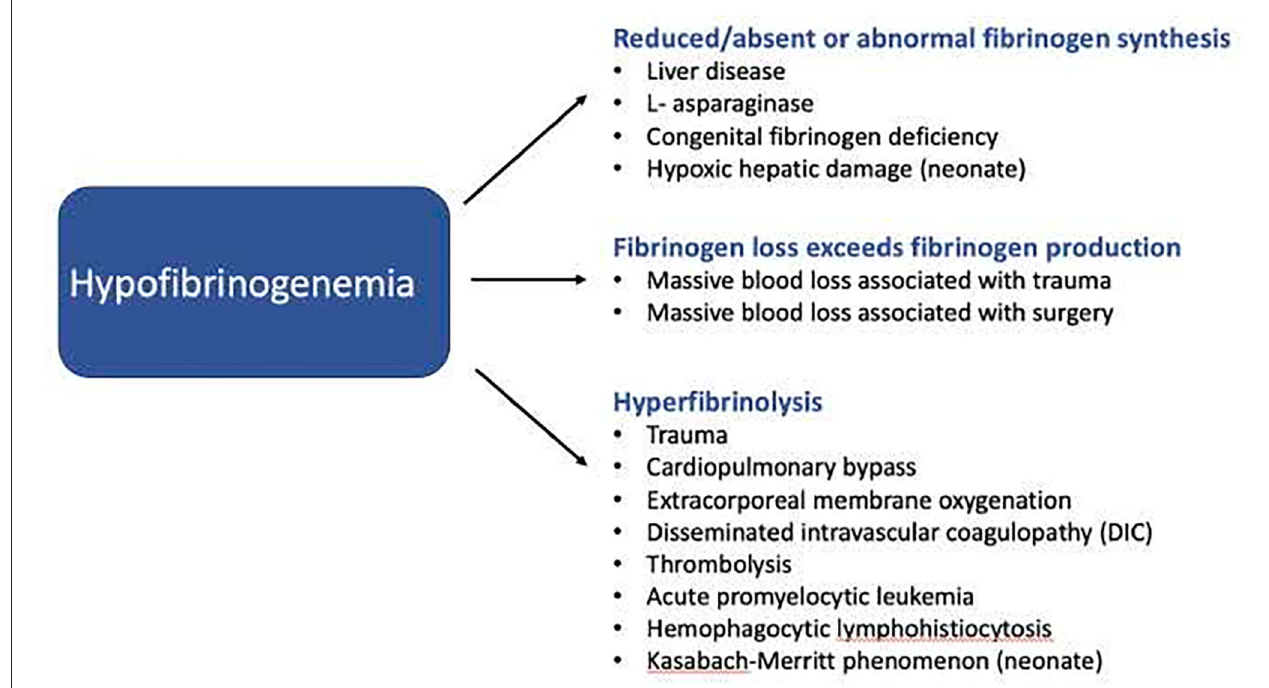
FIGURE 1 | Machanisms by which hypofibrinogenemia may develop in critically ill